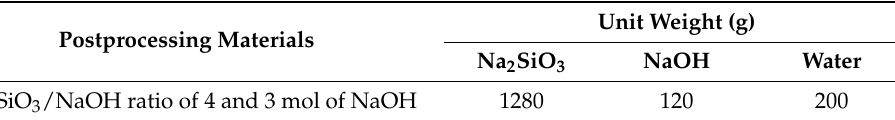
Table 3. Composition of postprocessing